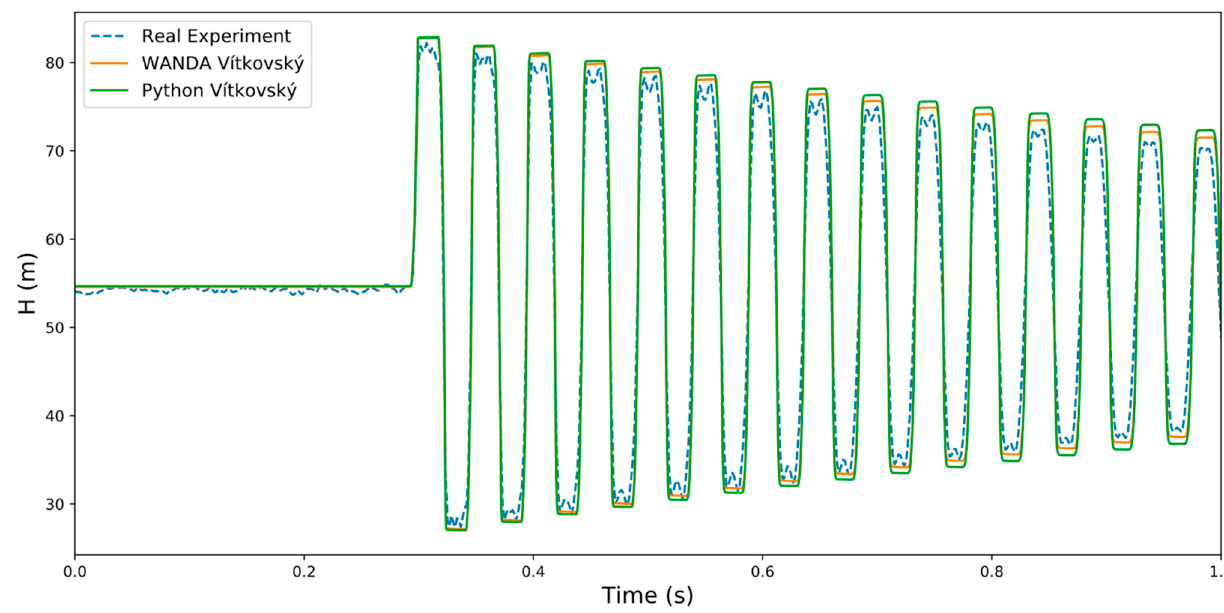
Figure 4. Vítkovský’s model in WANDA and Python. Figure 4. V í tkovsk ý ’s model in WANDA and